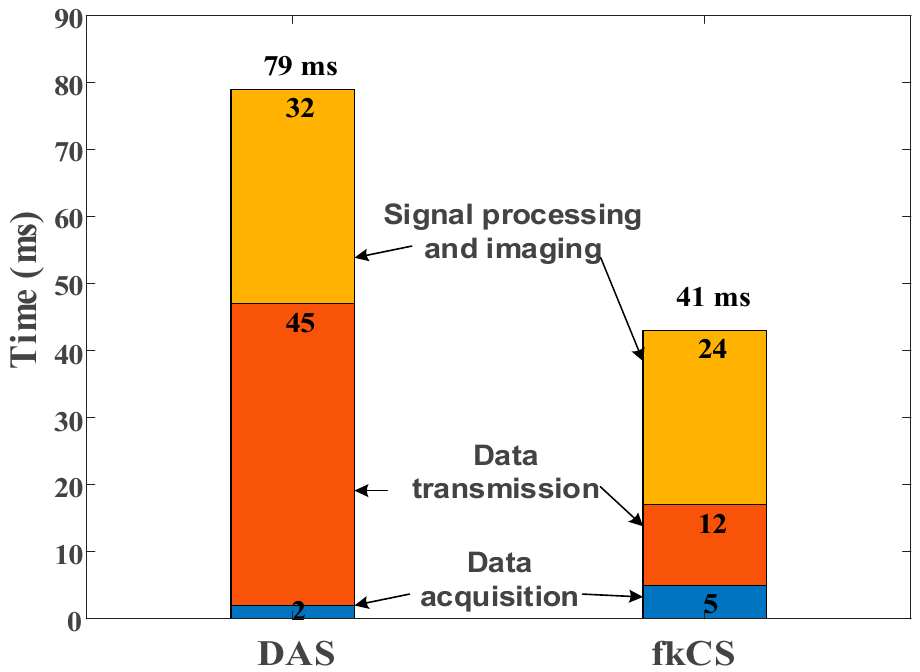
Figure 11. The time required to acquire one ultrasound image after averaging.